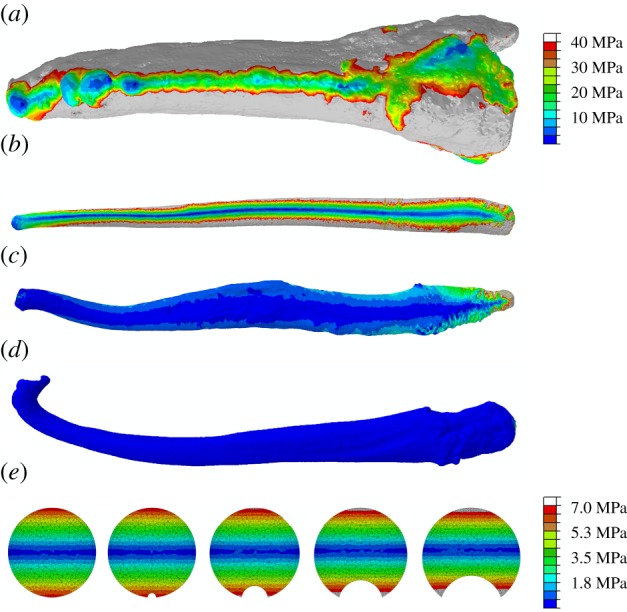
Von Mises stress maps. (a–d) Carnivoran bacula loaded under ventrally directed bending applied at the distal tip. Not to scale. (a) Panthera tigris; (b) Ursus arctos; (c) Canis lupus; (d) Mustela putorius. (a–d) Plotted on same colour scale, cool colours indicate Mustela putorius is considerably less stressed than Panthera tigris and Ursus arctos. Grey regions indicate stress has exceeded maximum value in legend. (e) Midshaft cross-sections through simple beam models of increasing groove depth. From left to right, groove depths of 0, 0.5, 1.5, 2.5 and 3.5 mm illustrated.